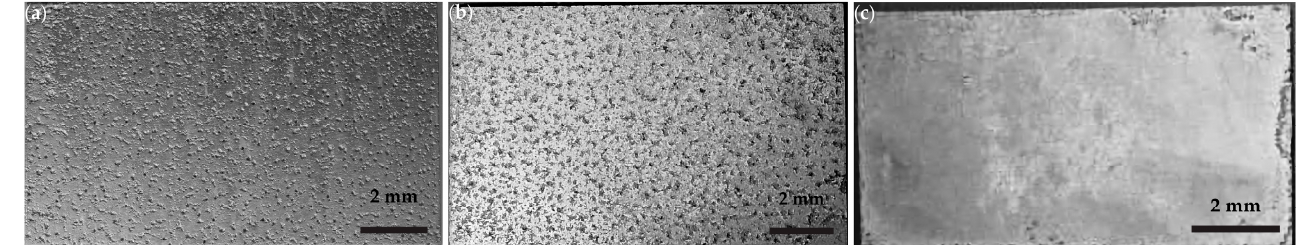
100.00 Figure 8. SAD patterns of β precipitate in alloy WE43-T5 showing: ( a ) [001]Mg//[1 − 10] β ZA patterns with corresponding [001]Mg simulation; ( b ) SAD pattern and simulation of the [362]Mg ZA with contributions from plural equivalent orientations of the β precipitates in the Mg matrix; ( c ) (1–20)Mg //(111) β orientation relationship and consistent with face-centered cubic β precipitates with a~ 22 Å